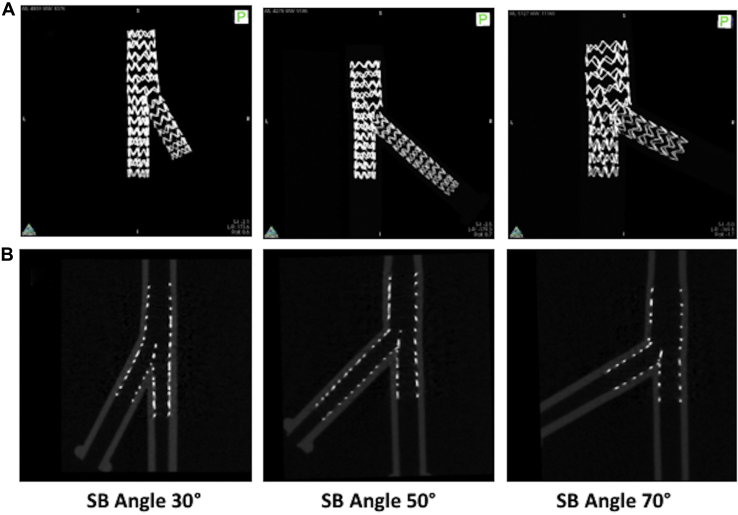
(A) Photographs of the key stages of the double-kissing nanocrush technique in a silicone bifurcation. (B) Microscopic computerized tomographic images of the deployments in silicone bifurcations deployments at 30, 50, and 70 degrees. SB, side branch.